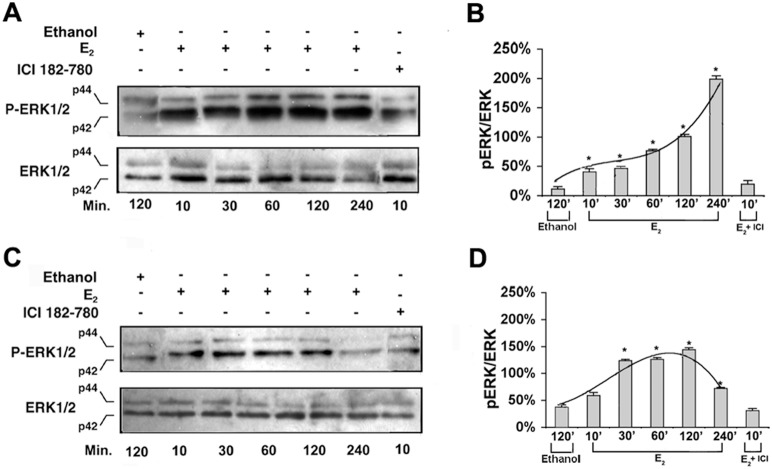
In mesPC, E2 induces ERK1/2 phosphorylation according to the proliferative/differentiation status.Western blot detection of p-ERK1/2 and ERK1/2 proteins in proliferating (A) and non-proliferating mesPC (C) treated at indicated time with 10 nM of E2 and 10 mM of ICI 182–780. Two specific bands were observed respectively at 44 and 42 kDa. Each blot is representative of three separate experiments. The diagrams show the relative quantization of p-ERK1/2 and ERK1/2 in proliferating (B) and non-proliferating primary cells (D). Data are expressed as ratios of p-ERK1-2/ERK1-2. In diagrams are also showed the different trend lines of the kinetic of p-ERK1/2 following E2 stimulation. Asterisks represent p<0.01 when compared to control cultures treated with vehicle (ANOVA, Scheffè F-test).